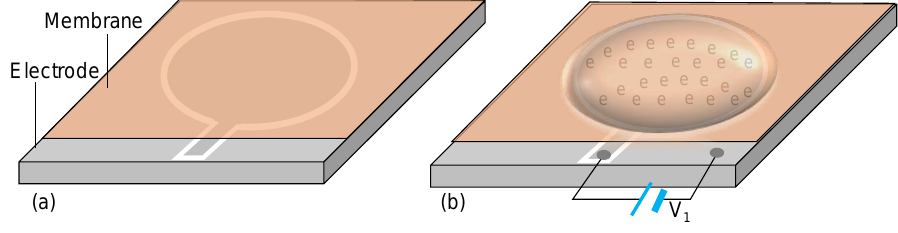
Figure 11. Structure and operation of a single lens in its array: ( a ) V = 0 and ( b ) V = V 1 .